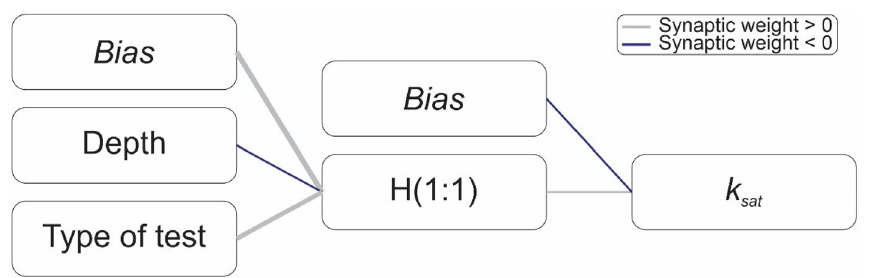
Figure 9. ANN approach for the evaluation of the hydraulic conductivity data of the lateritic